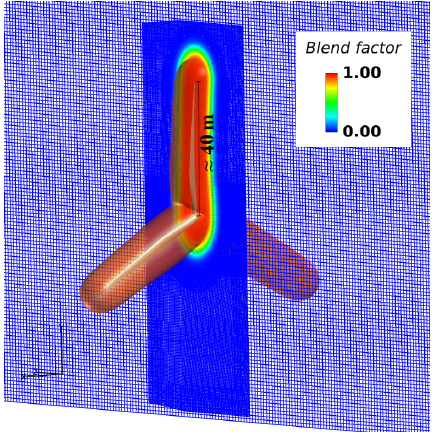
Figure 1. Blend factor, F h . Red: IDDES region. Blue: Deardorff LES region. Isosurface of F h = 0 . 9 ( ≈ 6m normal from surface).